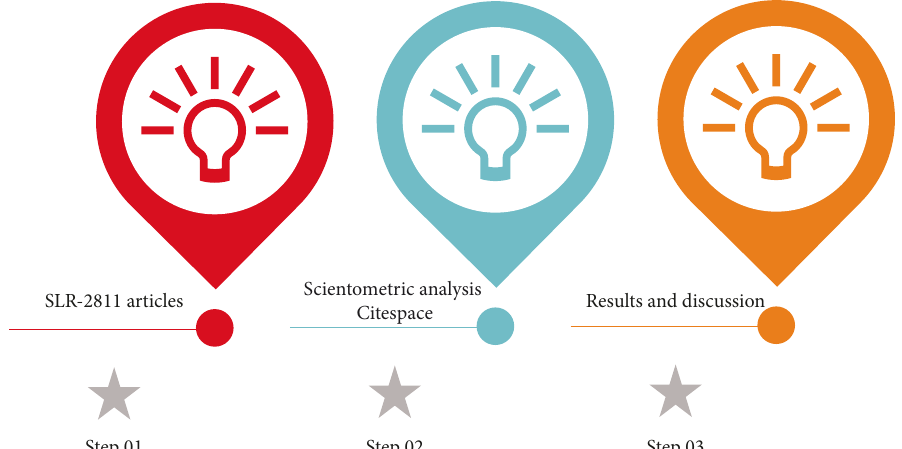
Figure 34: Science mapping analysis process.